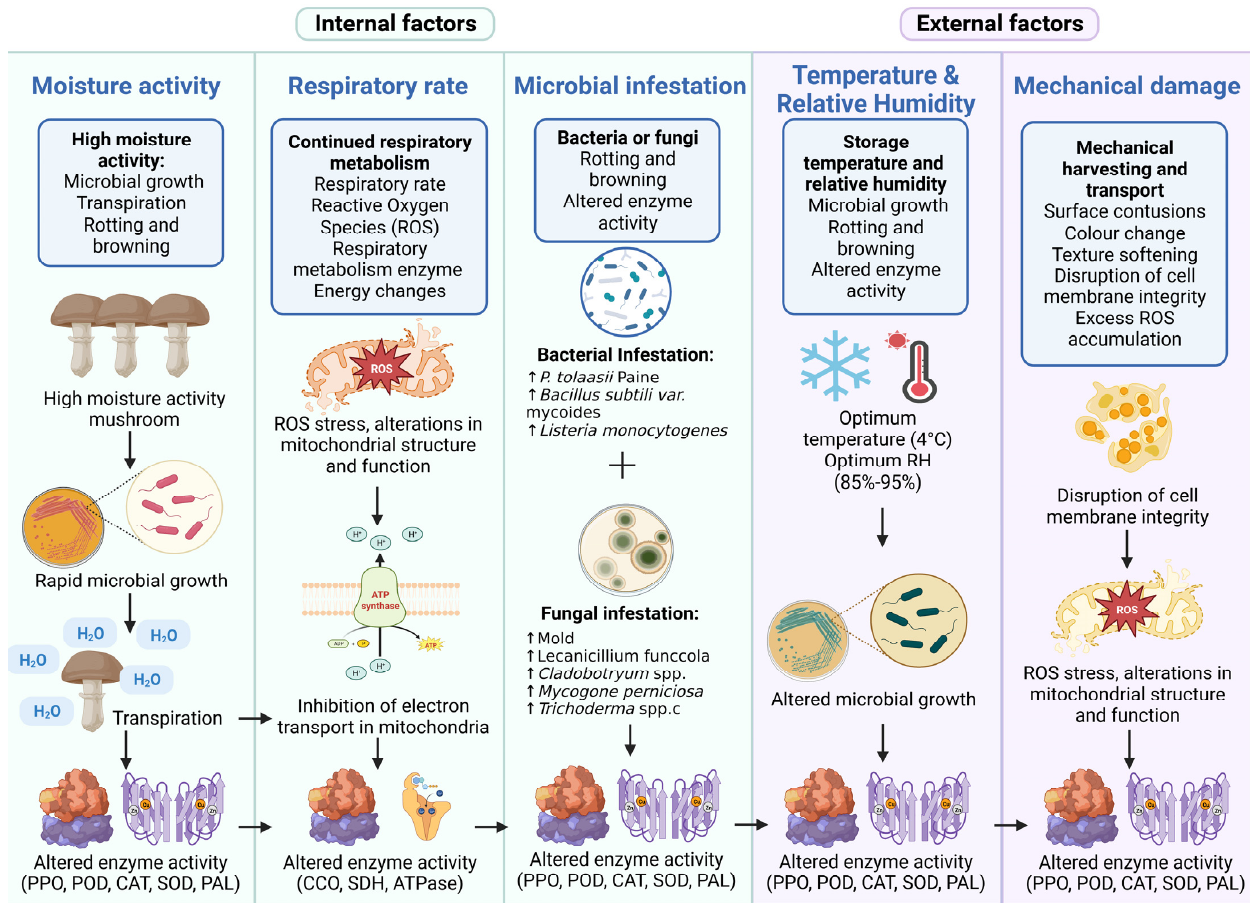
Figure 1. Factors influencing postharvest spoilage of edible mushrooms. (PPO: polyphenol oxidase; POD: peroxidase; CAT: catalase; SOD: superoxide dismutase; PAL: L-phenylalanine ammonia-lyase; CCO: cytochrome C oxidase; SDH: succinate dehydrogenase; ROS: reactive oxygen species.) Created with BioRender.com.